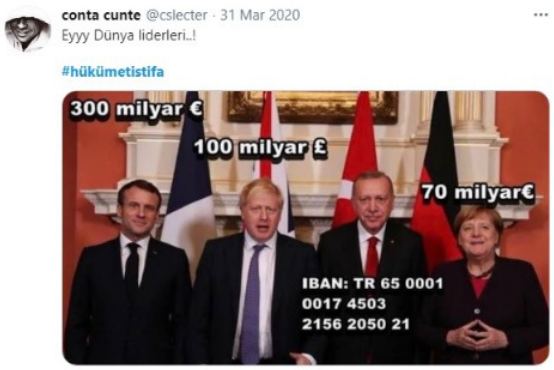
Figure 3. Humorous reaction for measures taken in Turkey against pandemic. Source: conta cunte